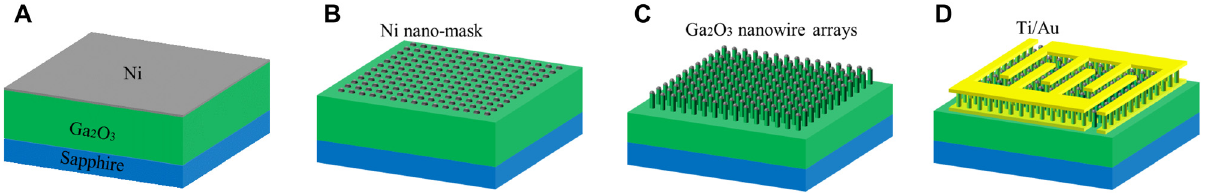
Figure 1: Schematicdiagramof the fabrication of β -Ga 2 O 3 nanowire arrays and the corresponding metal-semiconductor-metal photodetector (MSM